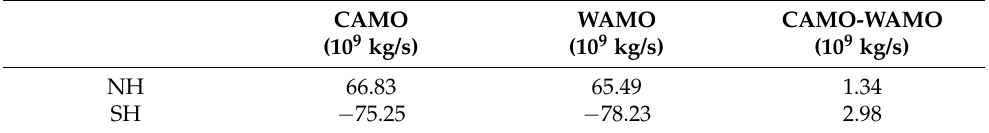
Table 2. Mean intensity of the Northern Hemisphere (NH) and the Southern Hemisphere (HS) Hadley cells calculated in terms of vertical-mean (900–200 hPa) and zonal-mean meridional stream function ψ (10 9 kg/s) for CAMO and WAMO experiments, and the differences between them. CAMO (10 9 kg/s)